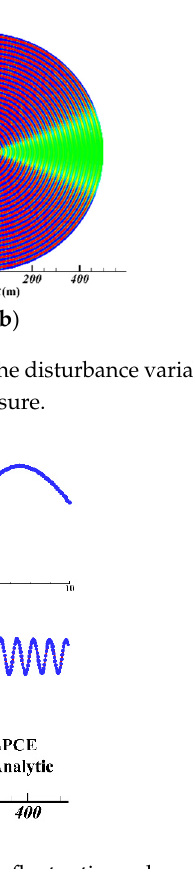
Figure 6. The instantaneous pressure fluctuations along the x = 0 line.